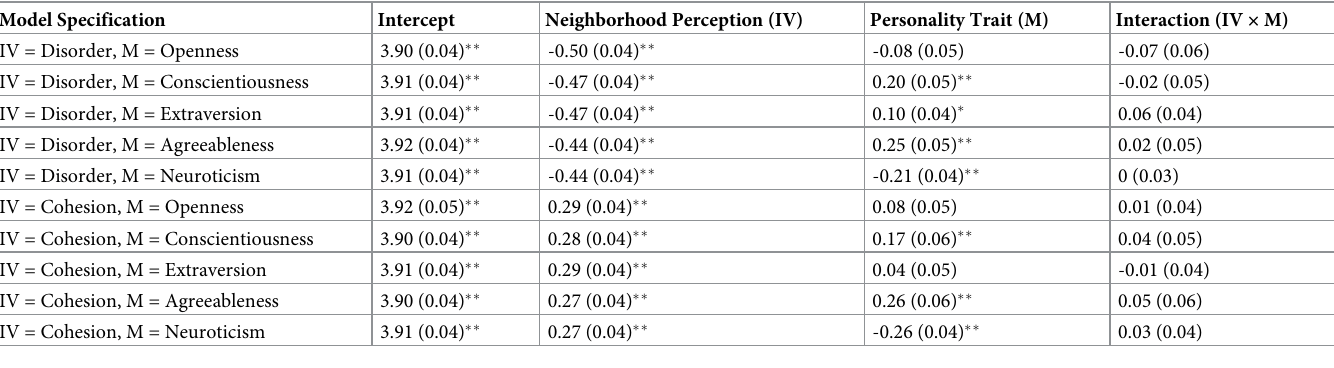
Table 3. Personality traits as moderators (M) of the association between neighborhood perceptions (IV) and neighborhood satisfaction (DV). Model